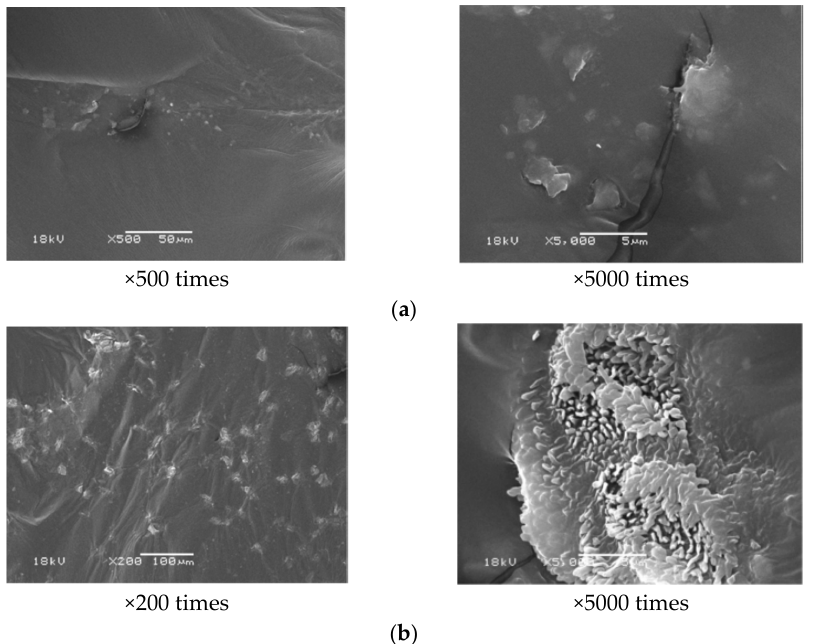
Figure 4. Microscopic image of aged and rejuvenated-asphalt [68]. ( a ) Aged asphalt, ( b ) rejuvenated asphalt. Table 18. Absorbance of key functional group [58].